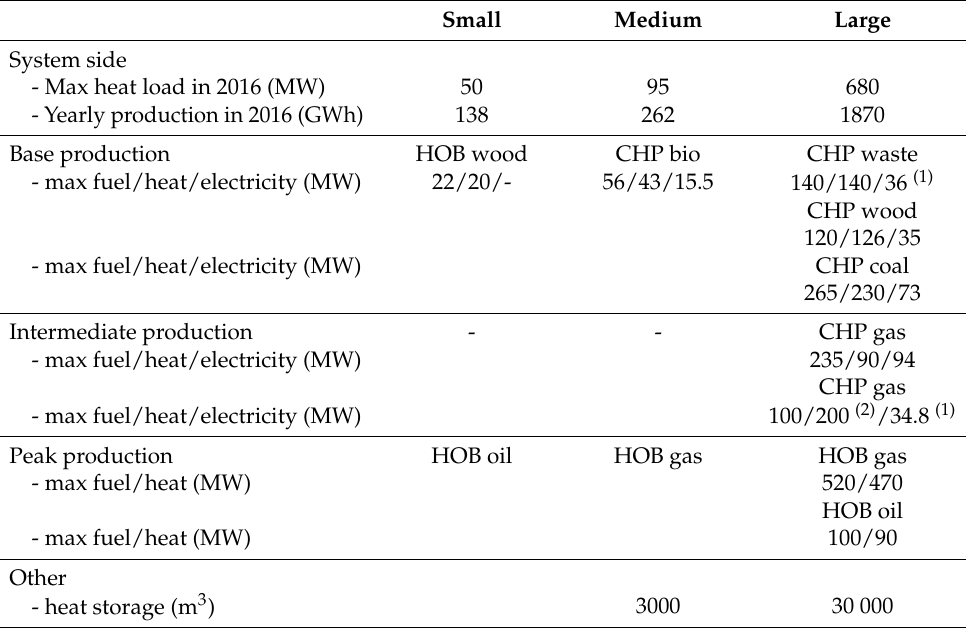
Table A1. Input values for heat production plants in simulations.